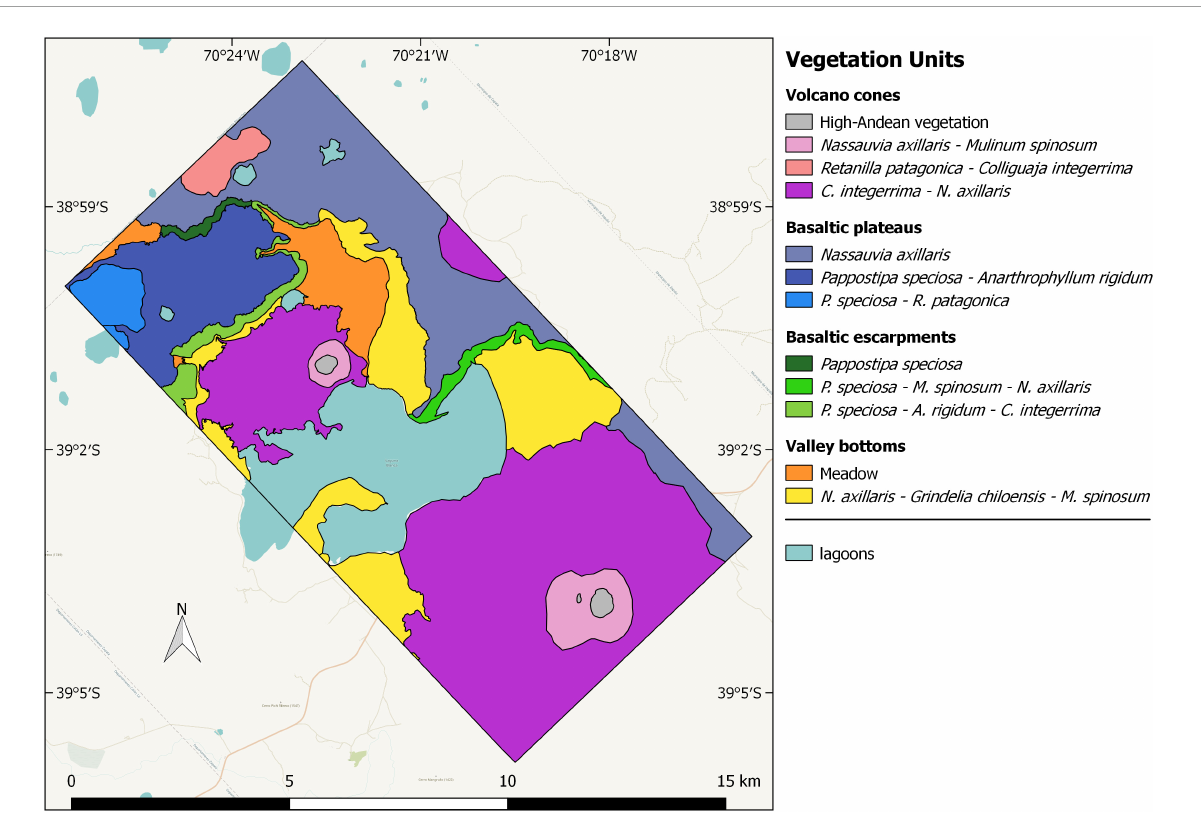
FIGURE3 Vegetation units of the LBNP [modified from Laguna Blanca National Park fire management plan (2017)].